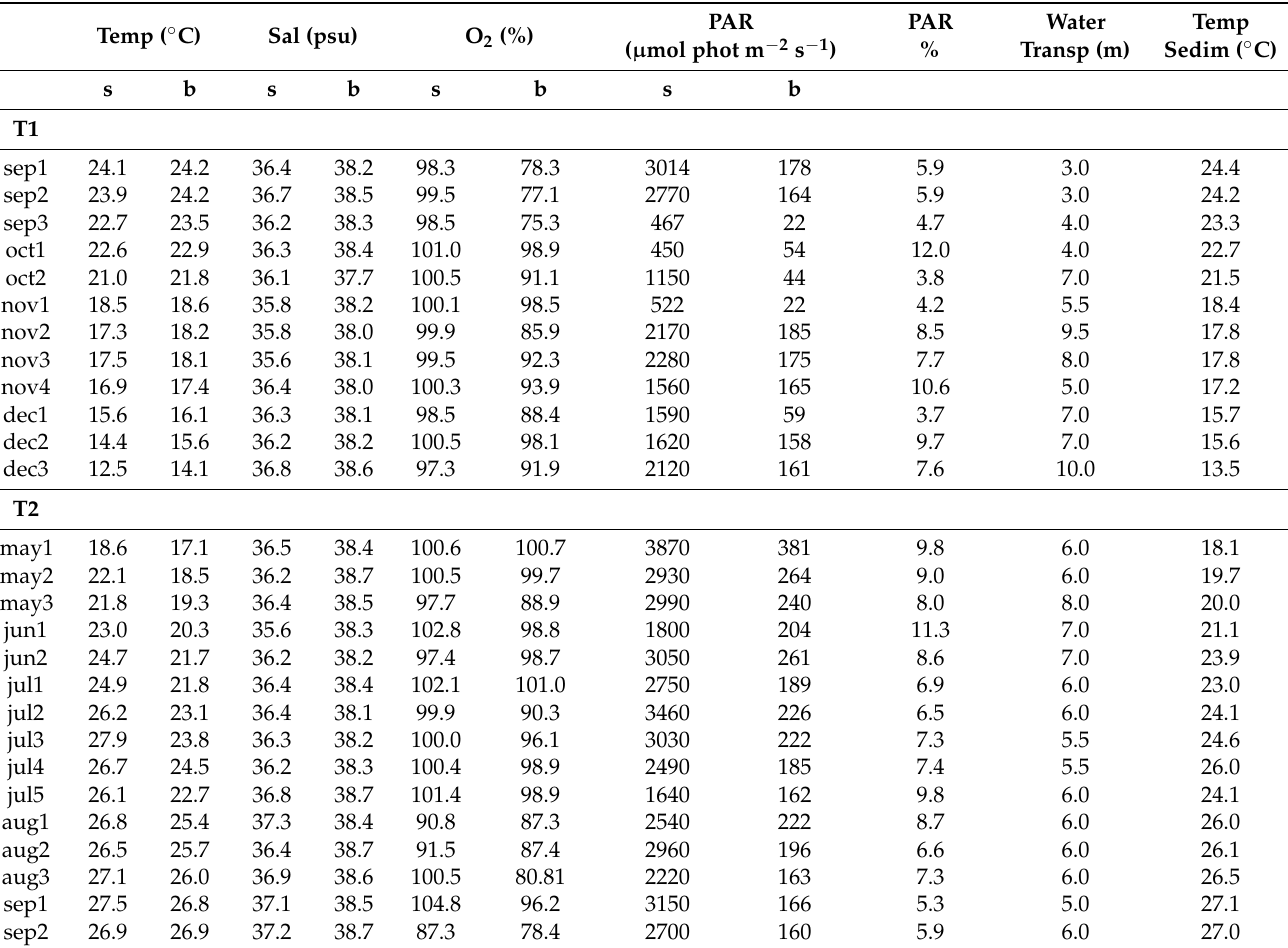
Table 2. Physical data measured at the surface (s) and close to the bottom (b) in the Mar Piccolo of Taranto in the dates of T1 and T2; PAR %, percentage of irradiance (photosynthetic active radiation) measured at the bottom vs. surface. Temp ( ◦